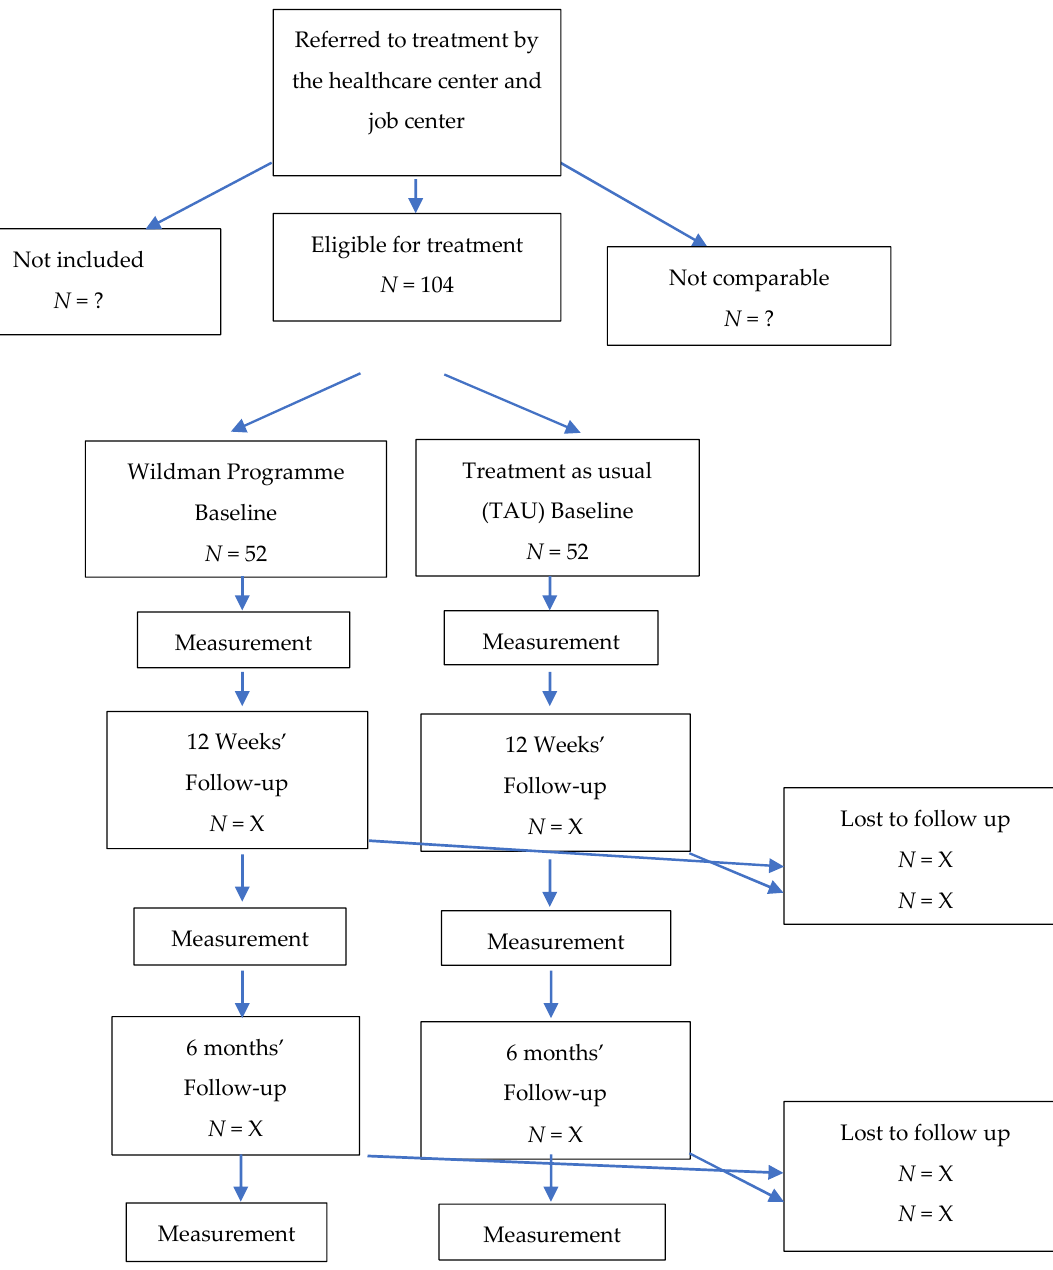
Figure 2. Flowchart for the study of the ‘Wildman